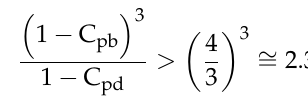
Figure 7. Variation of input power coefficient with loading coefficient.